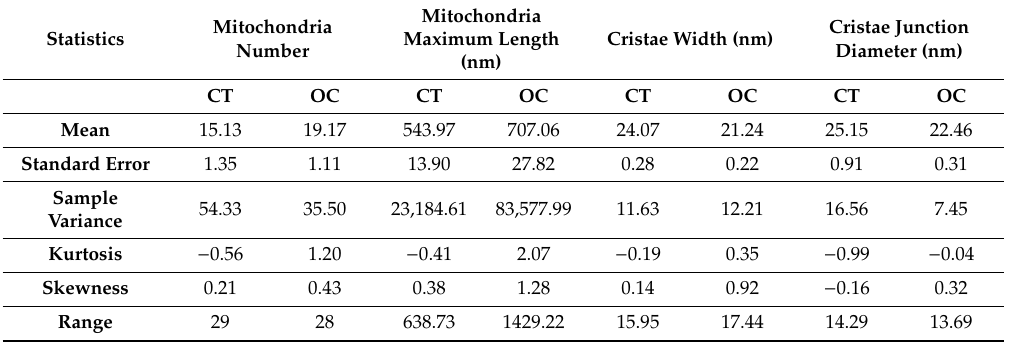
Table 1. Descriptive statistics for the mitochondria number, maximum length, cristae width, and cristae junction diameter in controls (CT) and ovarian cancer (OC).